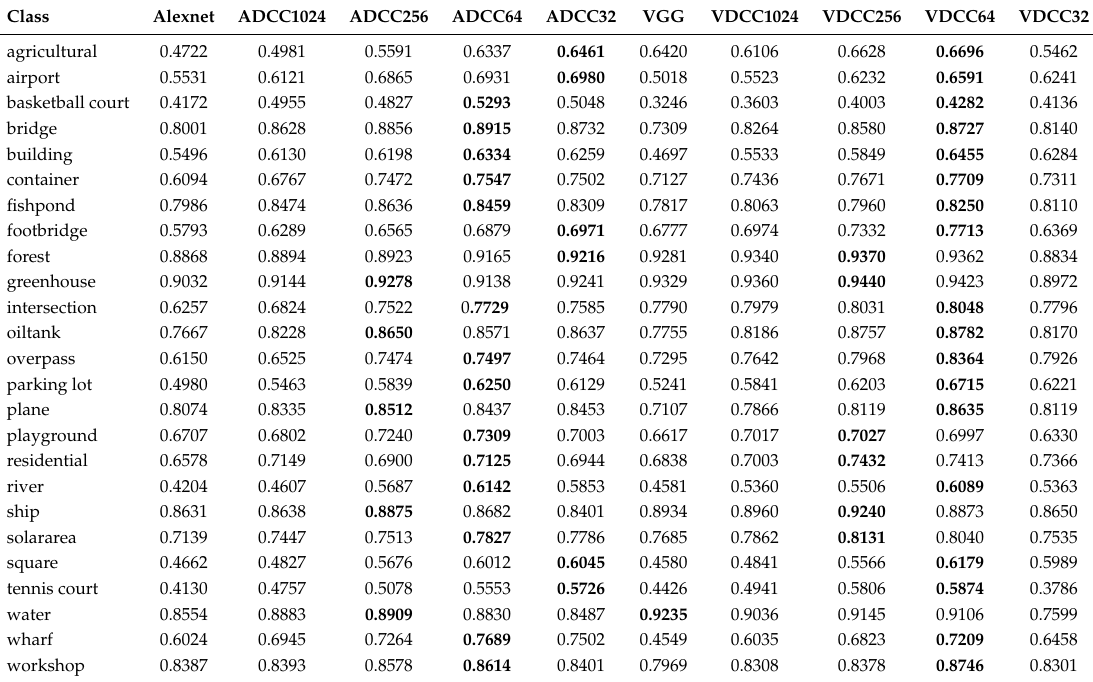
Table 2. P@150 values obtained using the models based on the Alexnet, VGG and corresponding DCC frameworks.